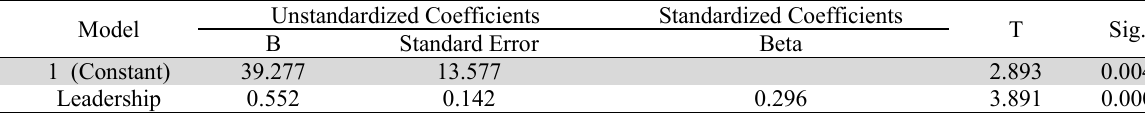
Coefficient leadership and performance Model